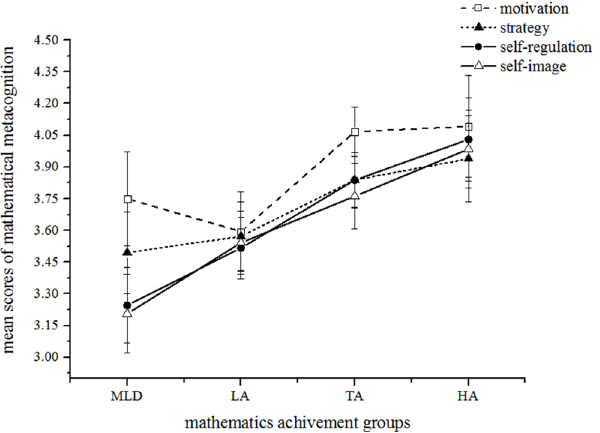
Fig 4. Mean scores for all dimensions of the mathematical metacognition of four mathematics achievement groups. MLD = mathematical learning difficulty, LA = low achieving, TA = typical achieving, HA = high achieving. LMA = learning mathematics anxiety, MEA = mathematical evaluation